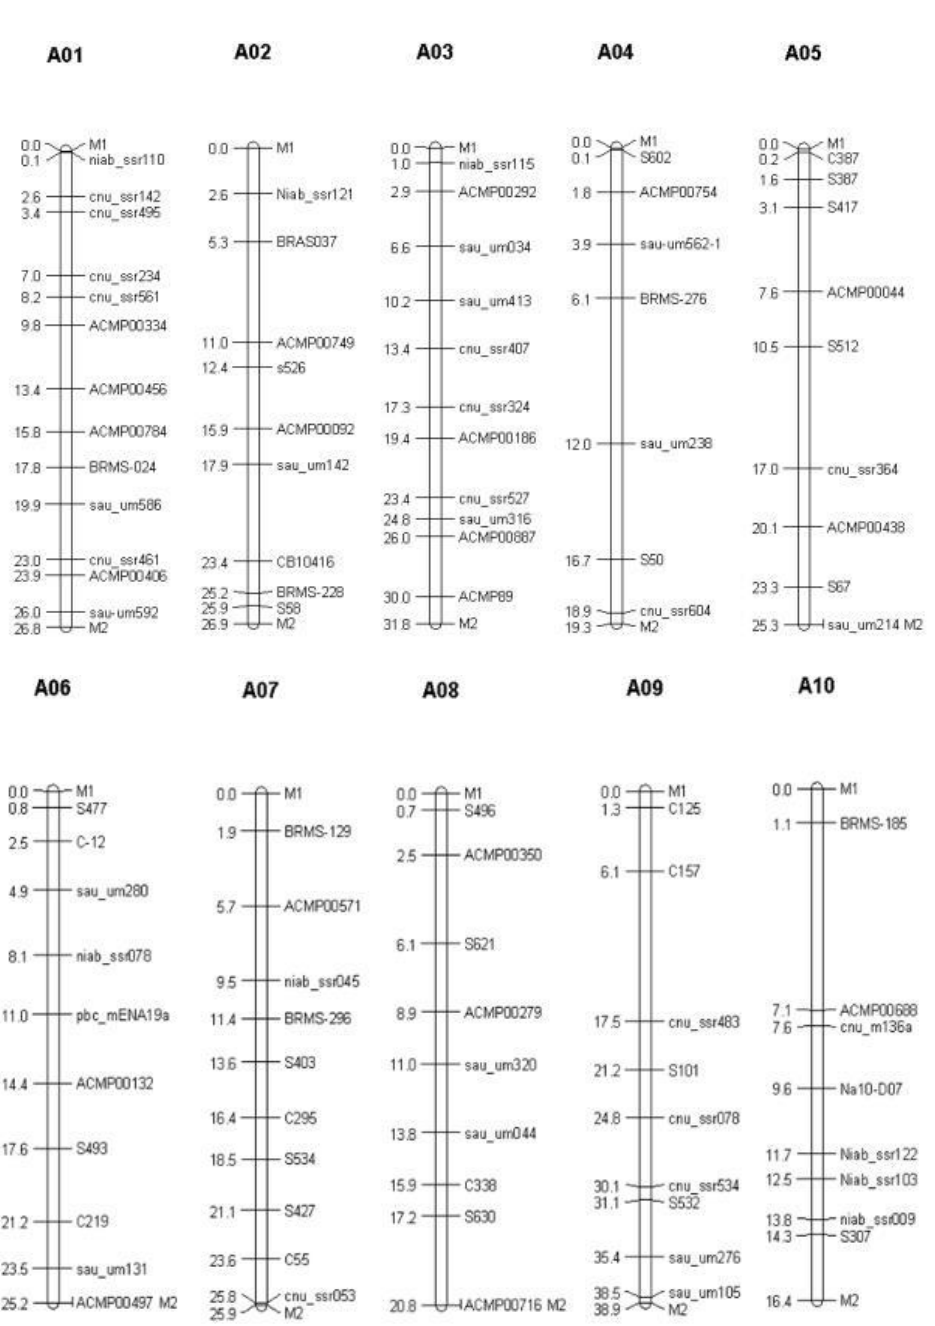
Figure 4. Distribution of background-selection markers in B. rapa chromosomes.